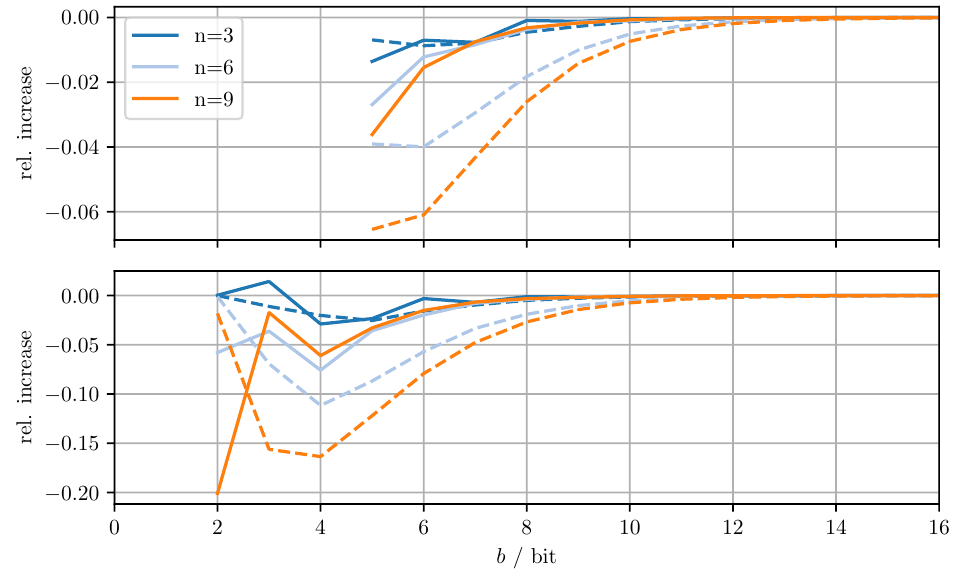
Figure 7. Relative increase of actual MSE (solid)/averaged trace (dashed) of MC-CI with respect to DD-CI for varying dimensions n and bits per codeword b . Top row with quantized estimate vector and quantized error covariance, bottom row only with quantized error